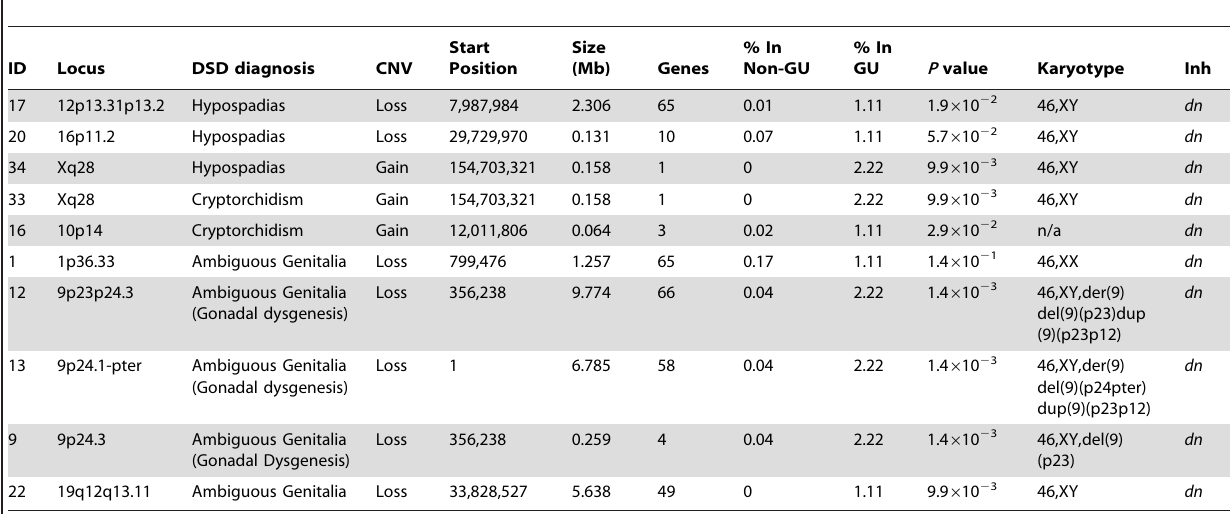
Footnotes: Minimal size of the spontaneous aberrations (Mb) and the number of the encompassing HGNC (Hugo Gene Nomenclature Committee) genes (G) (NCBI Build v35.1) were indicated. P values were based on two-tailed Fisher’s exact test comparing the frequency of each spontaneous event in cases versus controls. Significance threshold was set at P =5.0 6 10 2 2 . Abbreviations: Inh: Inheritance, dn : de novo.